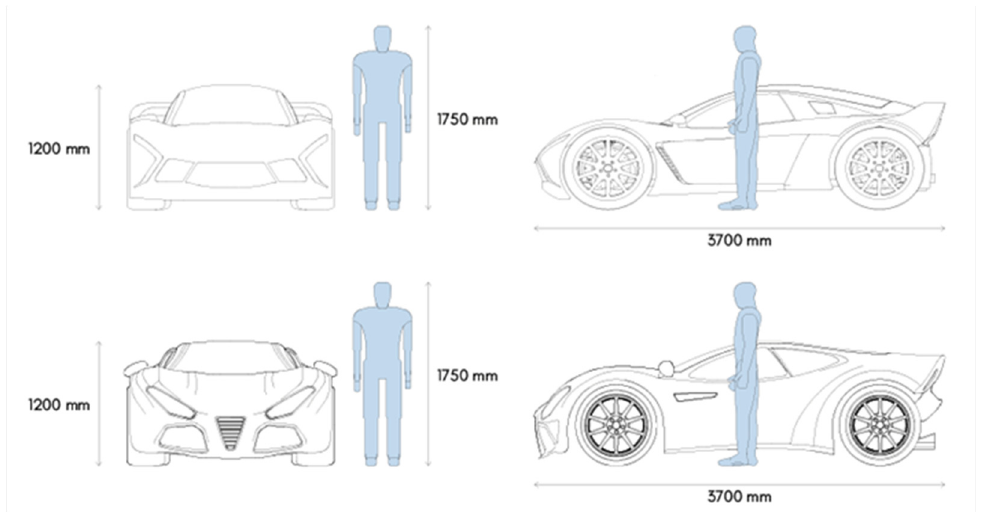
Figure 21. Vehicle/Human dimensions relationship.